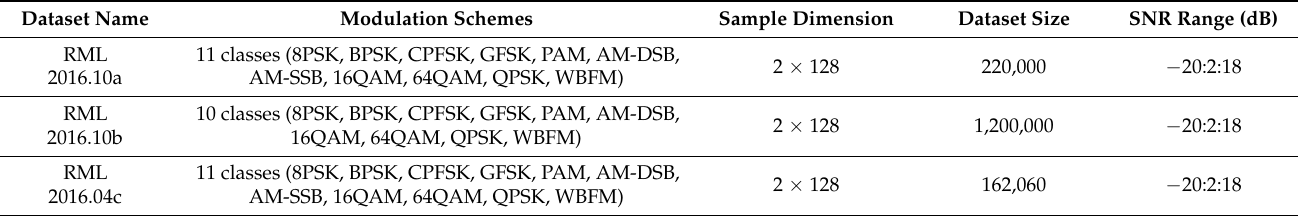
Table 1. Open-source modulation recognition dataset description